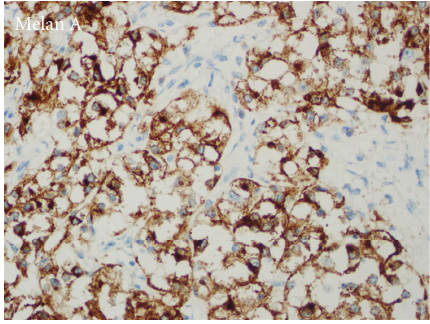
Figure 5: Melan-A positivity in perivascular tumor